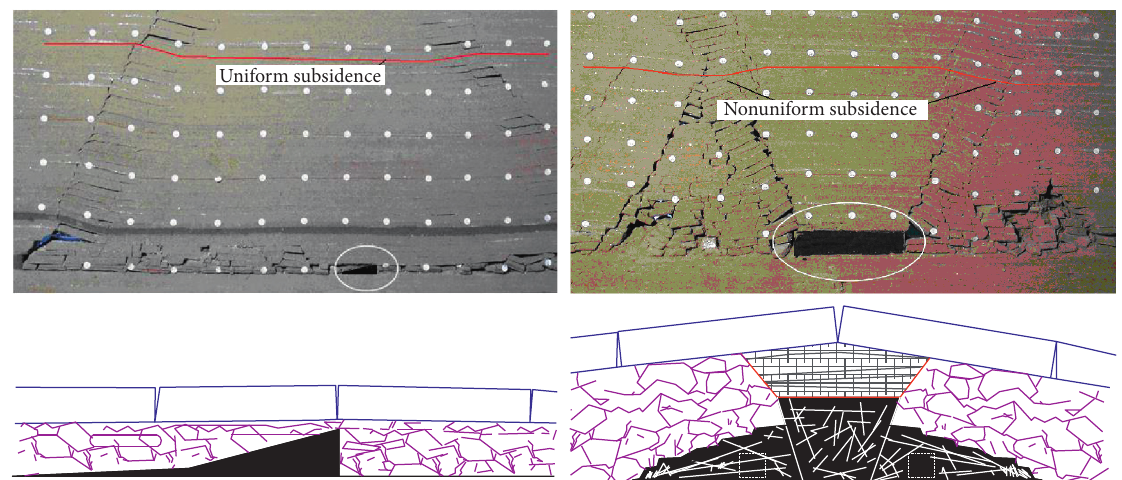
Figure 10: Subsidence characteristics in SLL and